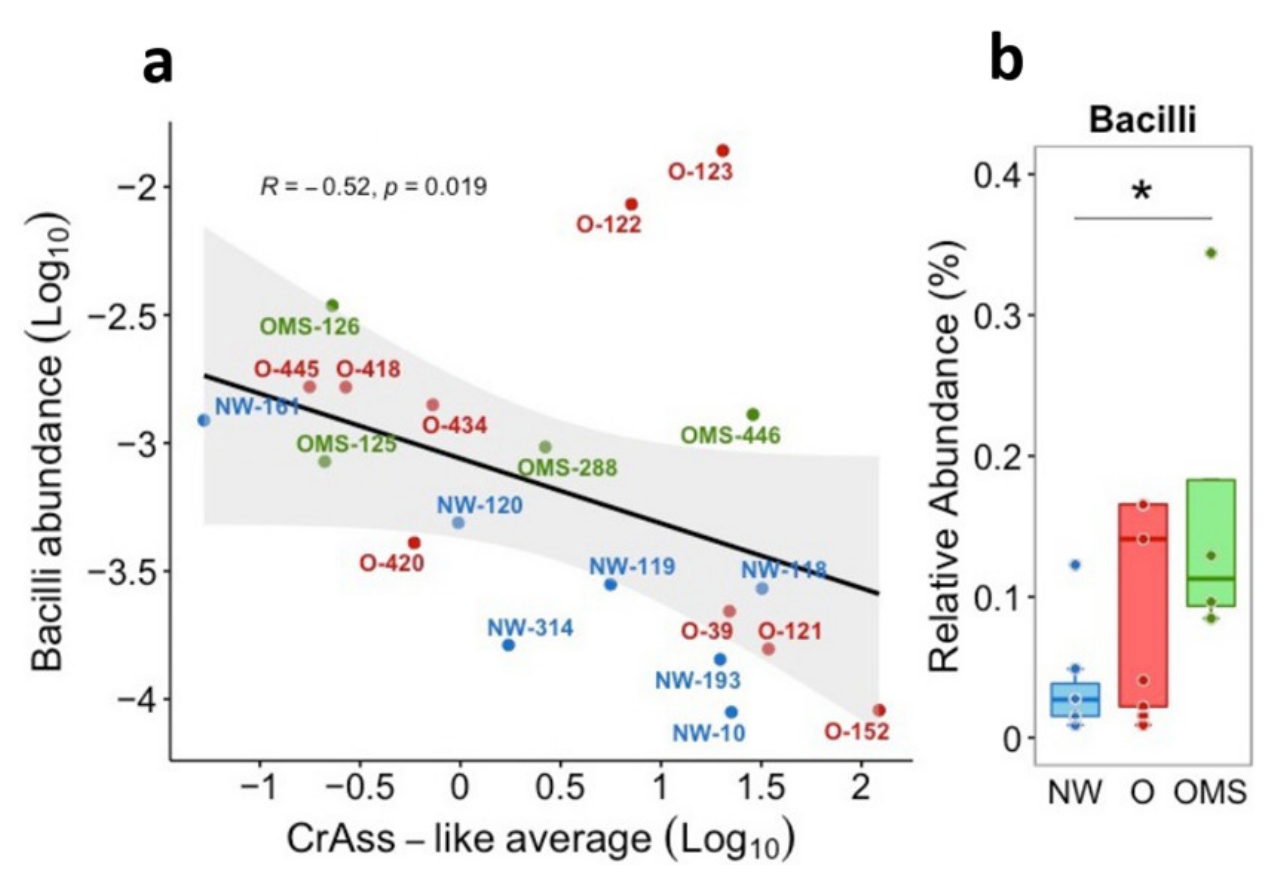
Figure 6. Relative abundance and Spearman correlation between the Bacilli and crAssphage genomes. ( a ) Spearman correlation plot between the Bacilli and crAssphage abundances. Blue circles = NW samples; red circles = O samples; green circles = OMS samples. ( b ) Relative abundance (%) of Bacilli. Each point shows the abundance for each sample, with the boxes showing the group’s distribution group (* p =0.024).